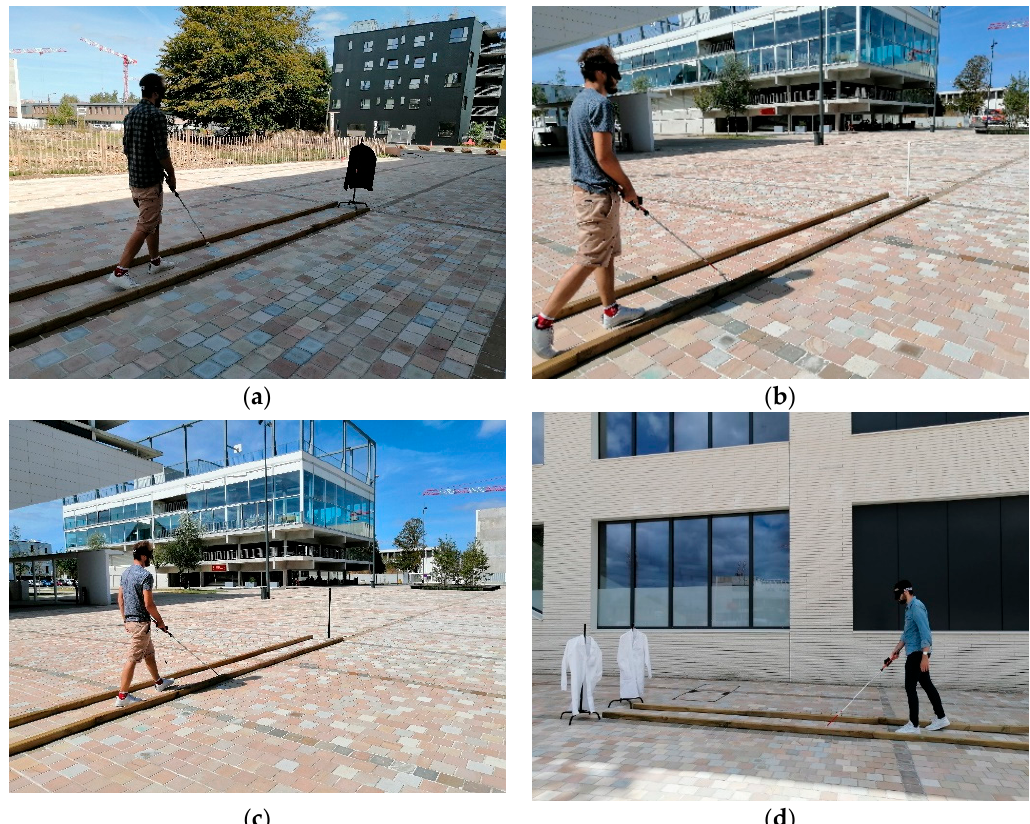
Figure 3. A sighted blindfolded participant sweeping the cane between the two bars at a given cadence to detect ( a ) a large dark obstacle under intermediate luminosity conditions; ( b ) a white thin post in full sunlight; ( c ) a dark thin post in full sunlight and ( d ) an aperture.